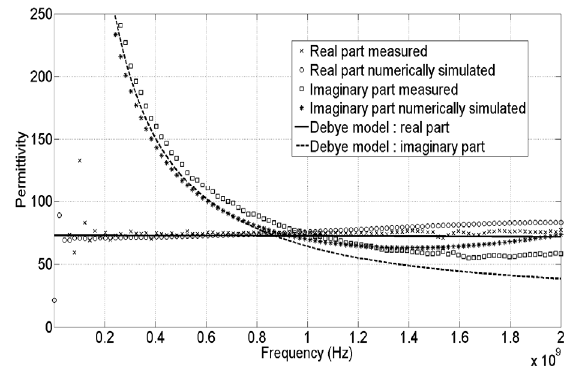
Figure 17. Measured and simulated permittivity of a concrete's interstitial liquid. Comparison with a Debye model. Figure 18. Real part of the calculated permittivity of samples with